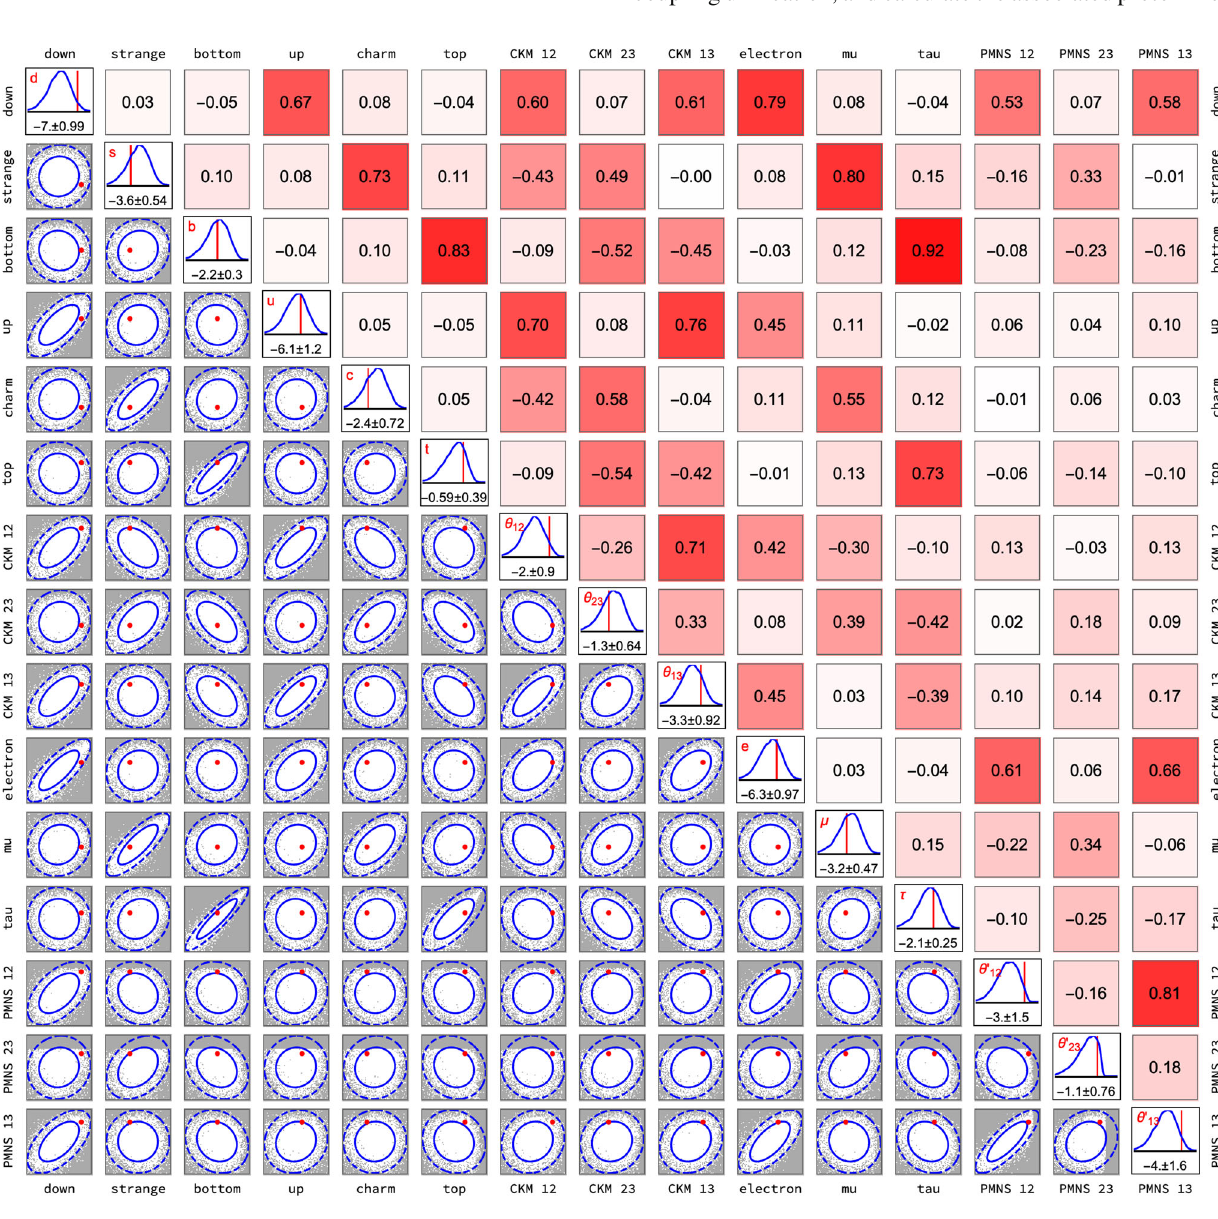
Fig. 6 The distribution of masses and mixings in the SO ( 10 ) model (parameters x i ), for the case N = 6. In the lower triangle, we display scatter plots of the two-dimensional marginal distributions, with the solid (dashed) contour representing one (two) sigma, and the red dots the experimental value. In the diagonal, we show the one dimensional